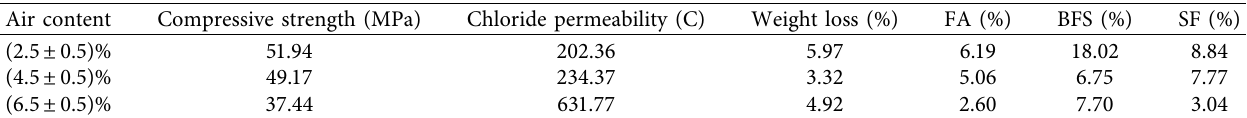
Table 9: The optimum mix proportions and predicted values of concrete under salt freeze-thaw